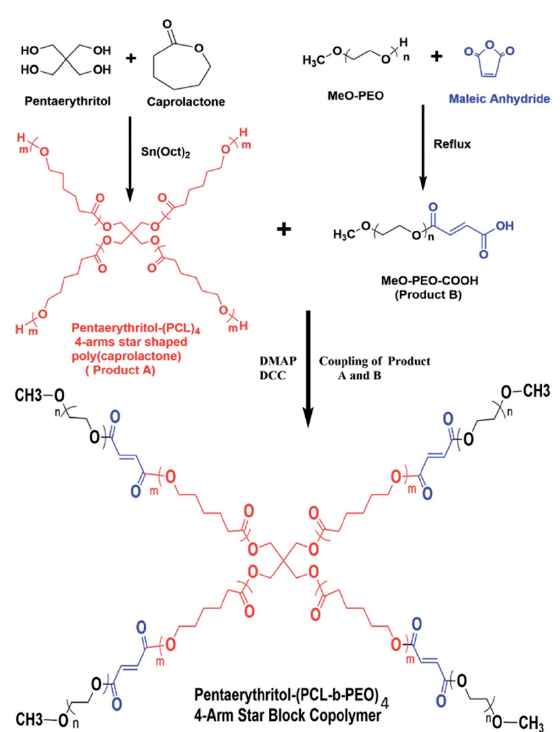
Figure 2. Synthesis scheme of 4-arm star-shaped block copolymer. Adapted from [24].